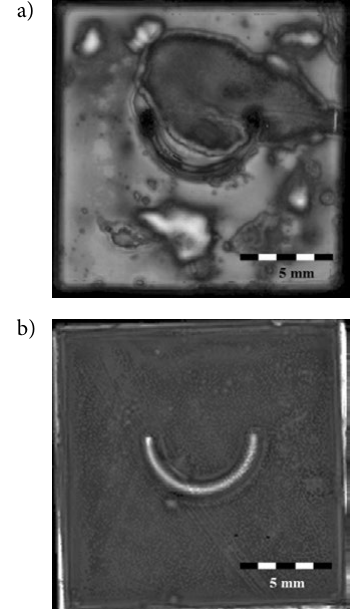
Fig. 8. On the SAM picture of the 13 th lamination method large delamination can be observed (a); the 18 th lamination method resulted in defect-free channel structure (b)